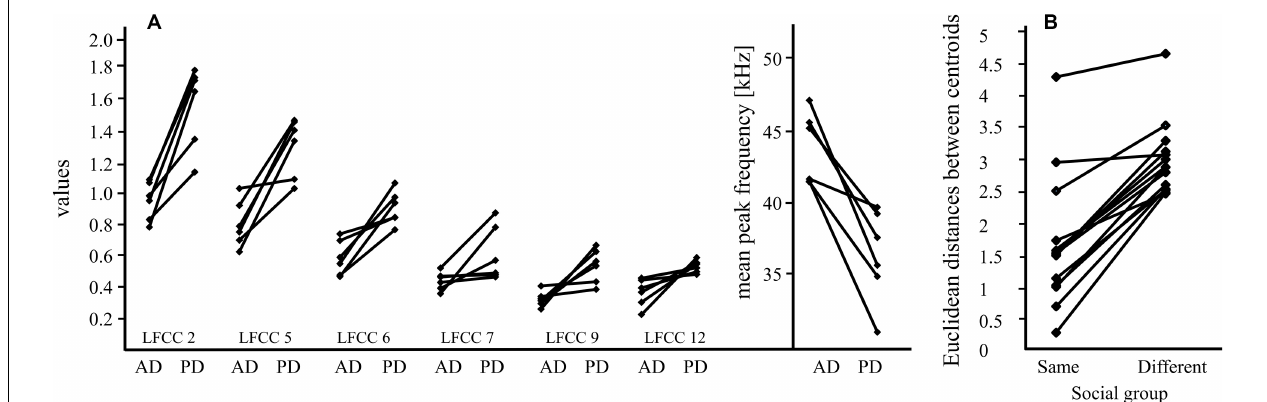
FIGURE 2 | Main results for pup-directed vocalizations of females and males. (A) Pup-directed (PD) and adult-directed (AD) vocalizations of six females differ significantly for six LFCCs (linear frequency cepstral coefficients; LFCC 2, 5, 6, 7, 9, and 12); this suggests that pup-directed vocalizations have different acoustic properties (e.g., timbre) than adult-directed vocalizations of the same individual. Means for each call category (PD, AD) and female are shown. The differences in peak frequency of PD and AD vocalizations (mean: PD vocalizations: 36.5 kHz, AD vocalizations: 44 kHz) are shown next to the LFCC results. (B) The Euclidean distance, a proxy for acoustic similarity, between isolation calls of pups and males from their social group is smaller than the distance between isolation calls of pups and males from a different social group; this indicates that isolation calls from males and pups of the same social group share a group signature. The data includes calls from 8 males and 14 pups.